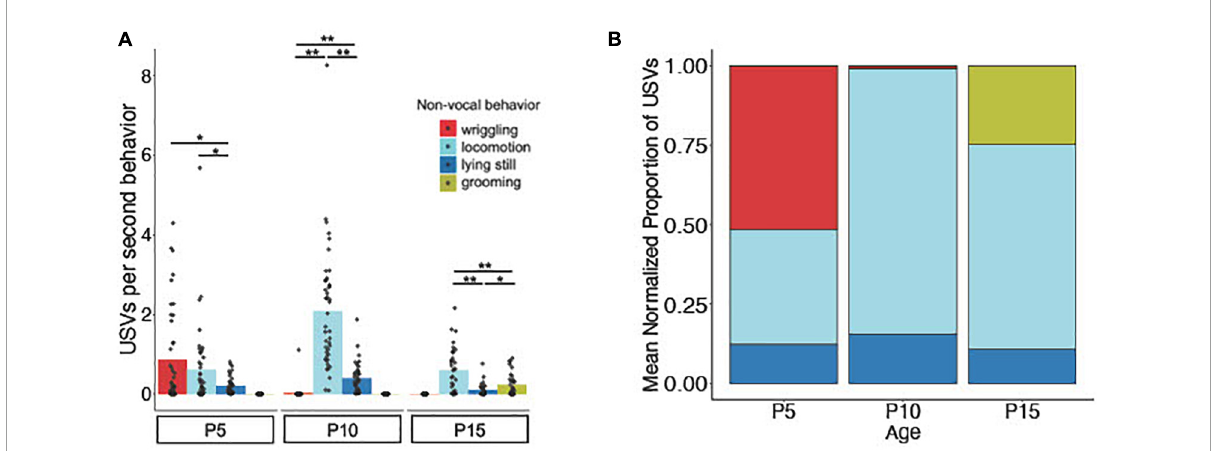
FIGURE3 Relationship of USV rates to non-vocal behaviors. (A) The mean number of isolation USVs produced per second engaged in four non-vocal behaviors (wriggling, locomotion, lying still, and grooming; see Methods) is shown for P5 ( N = 42), P10 ( N = 44), and P15 ( N = 44) mice. (B) Stacked bar plot showing the mean proportion of total USVs produced during each non-vocal behavior normalized by the amount of time each mouse spent performing that behavior. Single asterisk, p < 0.05; double asterisks, p <